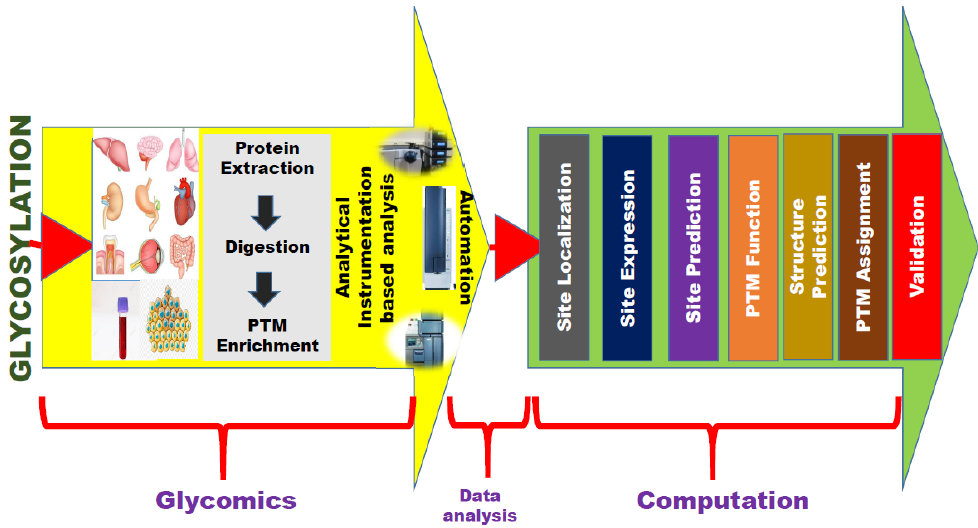
Figure 3. Work-flow of glycosylation research, beginning from wet lab analysis—instrumentational analysis culmination in bioinformatics based computation (data analysis).